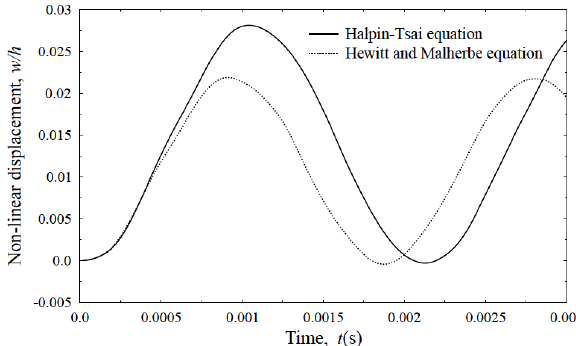
Figure 4: Comparison of nonlinear transient displacements ( w / h ) of SWCNT reinforced composite spherical shells ( R / a = 10 ) for different multiscale models ( q = 1.0 MPa, [0/90] s , V f = 0.8 , w cnt = 1.0% no cutout).